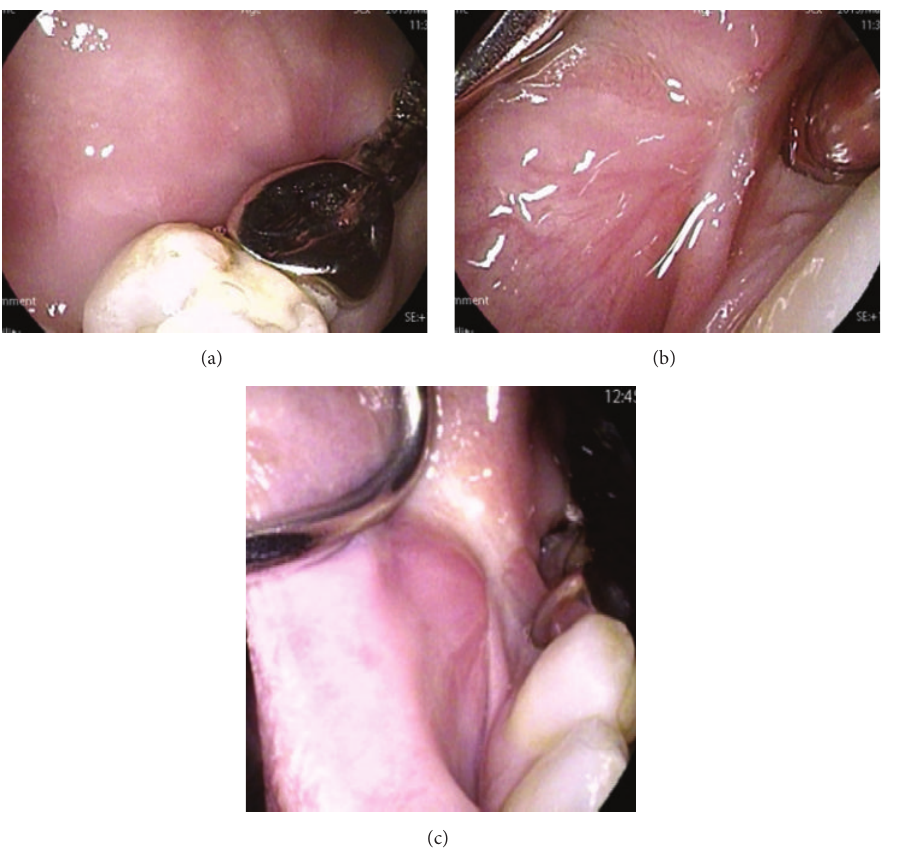
Figure 5: Postoperative local findings. Stable epithelialization of the wound by renewed buccal mucosa was observed. Good wound healing was also noted ((a) and (b) three months later, (c) five months